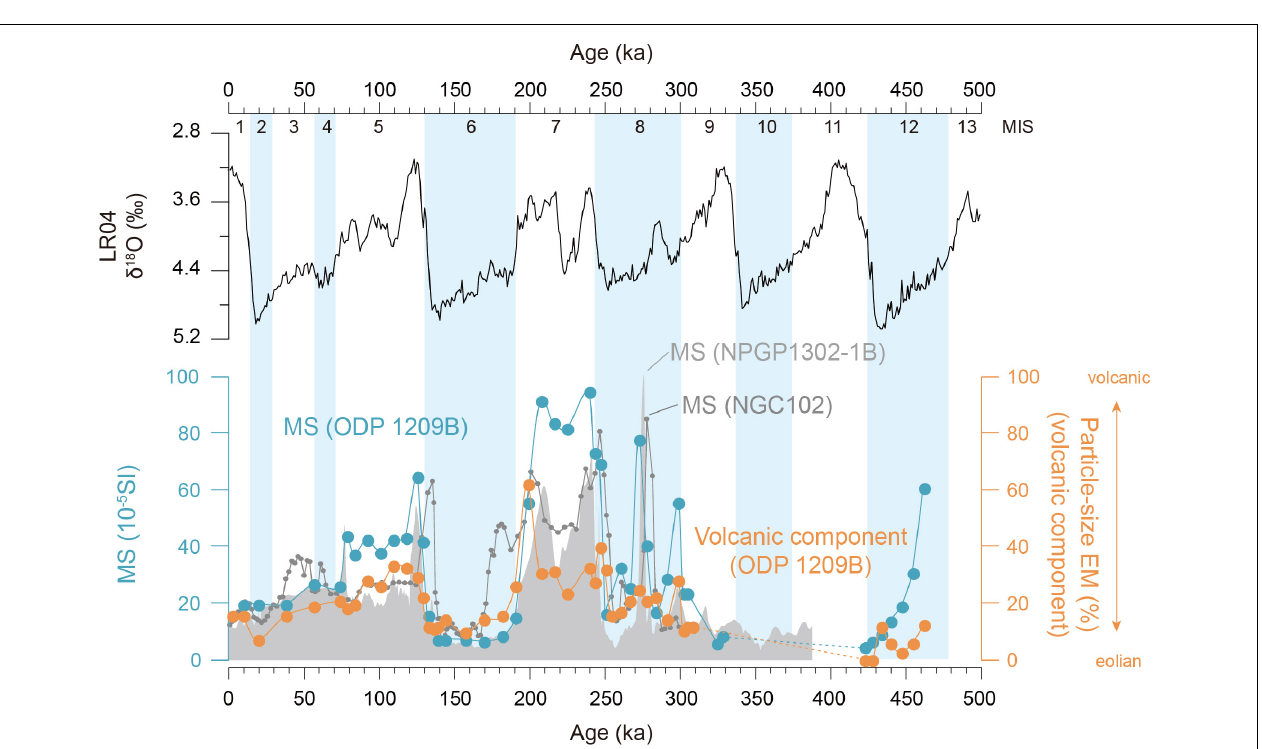
FIGURE 6 | Correlation between bulk magnetic concentration (SIRM, HIRM 300 , and HIRM 100 ) and PMCs of (A) coarse (8–31 and 31–63 µ m) and (B) fine ( < 2 and 2–8 µ m) fractions. Glacial samples (MIS 6, 8, and 10), suspected to be altered (open symbols), were excepted for the correlation. PMCs of coarse and fine fractions reveal positive and negative correlations, respectively, with bulk concentration parameters.